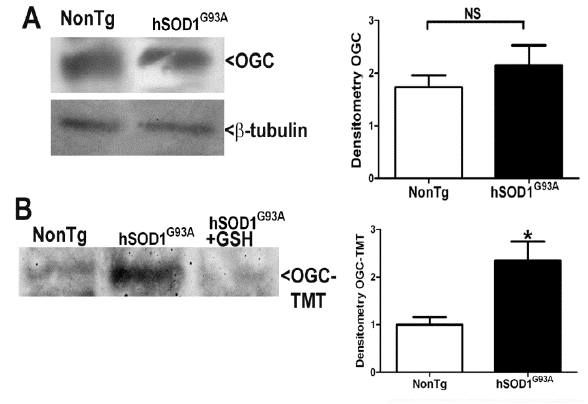
Figure 6. OGC is S ‐ nitrosylated in lumbar spinal cord from end ‐ stage G93A mutant hSOD1 mice. ( A ) Lumbar spinal cord tissue from non ‐ transgenic (NonTg; FVB/NJ) and end ‐ stage G93A mutant hSOD1 mice (hSOD1G93A) was lysed and equal protein amounts were resolved by SDS ‐ PAGE and immunoblotted against OGC and β‐ tubulin. Densitometry was completed to measure OGC band intensity normalized to β‐ tubulin. NS = not significant via an unpaired Student’s t ‐ test, n = 4. ( B ) Whole lumbar spinal cord from NonTg and end ‐ stage hSOD1G93A mice was lysed and immuno ‐ precipitated (IP’d) for OGC. IP’d OGC was modified using the Iodo ‐ TMT S ‐ nitrosylation kit from Pierce ThermoFisher as per the manufacturer’s recommendations. IP’d and modified protein was resolved via SDS ‐ PAGE and immunoblotted for TMT. GSH was added to one reaction as a negative control. Densitometric analysis of TMT ‐ labeled OGC was performed. * p < 0.05 versus NonTg via an unpaired student’s t ‐ test, n = 4.